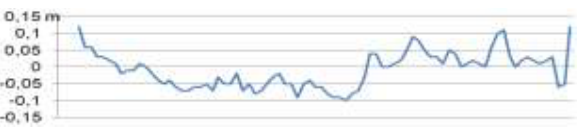
Figure 11. Averaged Kompsat-3 y-parallax over 8km in N-S